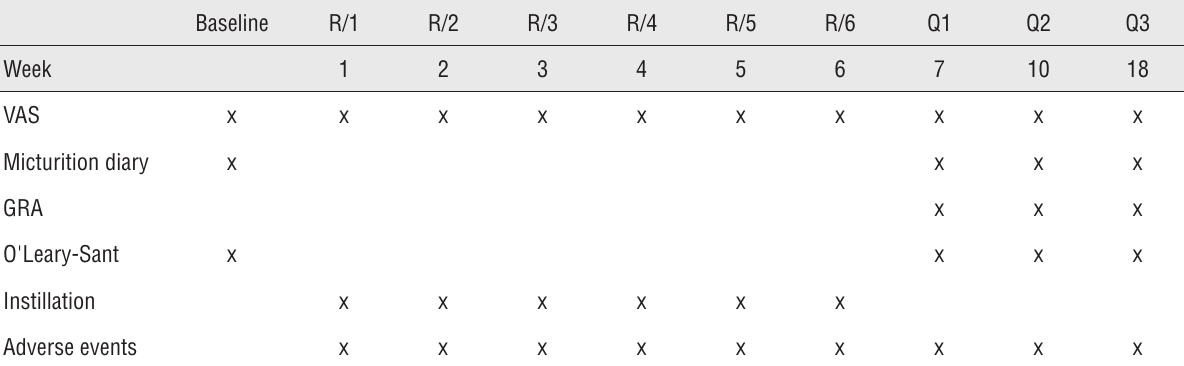
Table 1 - Study overview.